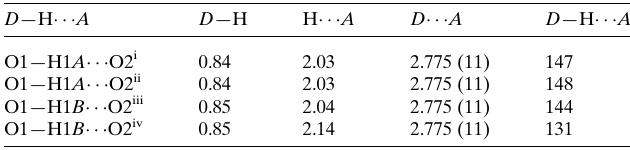
Table 2 Experimental